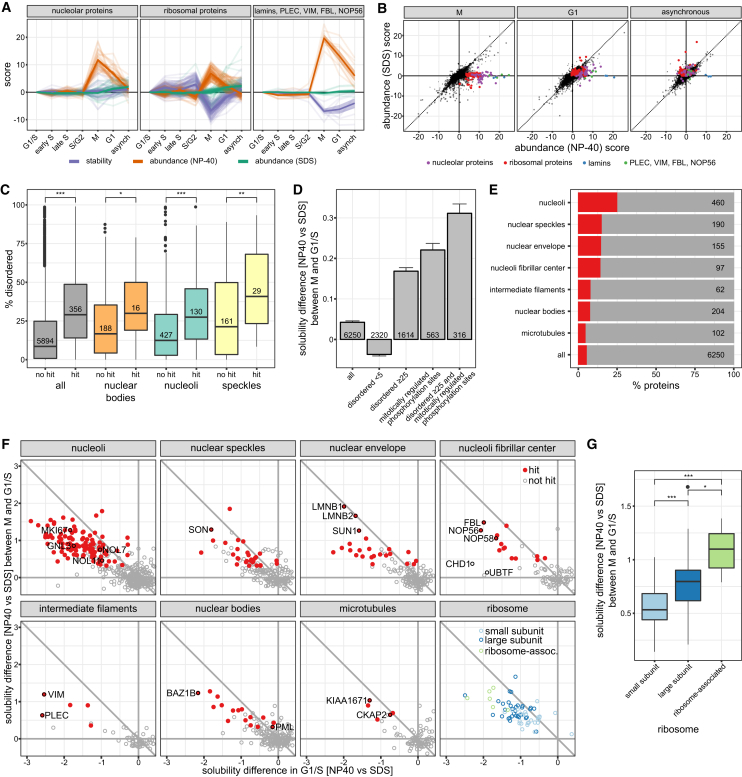
Solubility Transitioning Proteome(A) Abundance (measured in NP-40 lysis buffer in orange and SDS lysis buffer in green) and stability (purple) profiles of three protein groups (nucleolar, ribosomal, or lamins and others from cluster 19, 20, or 21 as shown in Figure 2E, respectively) are shown across all cell-cycle stages.(B) Scatterplot depicting the abundance scores in SDS lysis (y axis) versus abundance scores from NP-40 lysis (x axis) for each protein. The indicated functional groups are solubilized during mitosis, but not in G1, except for lamins, which also remain soluble during G1 phase.(C) Boxplots of relative coverage of disordered regions for proteins significantly changing in solubility in mitosis versus G1/S compared to other proteins. Comparisons are made for all proteins, as well as for proteins located within different membraneless organelles as defined by the Human Protein Atlas (HPA).(D) Solubility differences in mitosis versus G1/S for proteins with different levels of disordered regions in their sequence and containing mitotic phosphorylation sites. SEM is shown.(E) Percentage of the proteomes of different organelles significantly changing in solubility in mitosis versus G1/S and localization as defined by HPA, except for the nuclear envelope, which combines nuclear membrane annotated proteins as defined by HPA and proteins annotated as inner nuclear membrane proteins by Wilkie et al. (2011).(F) Scatterplots comparing the solubility of proteins in G1/S and the relative change in solubility of proteins in mitosis versus G1/S for different organelles, the cytoplasmic ribosomal subunits, and the ribosome-associated complex determined by Havugimana et al. (2012) (BOP1, RRS1, GNL3, EBNA1BP2, FTSJ3, MKI67). Proteins with negative x axis values and close to zero y axis values are insoluble in G1/S and remain insoluble in mitosis. Proteins with negative x axis values and positive y axis values are insoluble in G1/S and become more soluble in mitosis. Proteins that are significantly more soluble in mitosis compared to G1/S are marked in red.(G) Solubility differences in mitosis versus G1/S compared between proteins from the small and large cytoplasmic ribosomal subunits and the ribosome associated complex determined by Havugimana et al. (2012).See also Figure S7 and Tables S3 and S7.